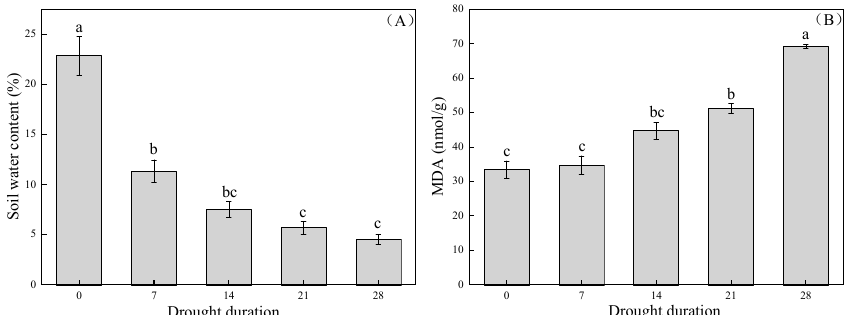
Figure 6. Changes in soil water content ( A ) and malondialdehyde (MDA) ( B ) with di ff erent durations of drought. Di ff erent lower-case letters denote significance levels based on analysis of variance (ANOVA) post hoc means with least significant di ff erence (LSD) analysis ( p < 0.05). Data are means with standard error.